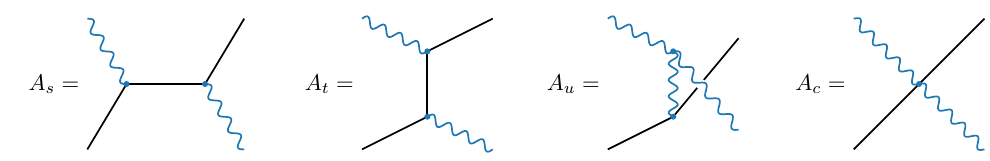
Figure 5. Illustration of the different contributions to gravitational Compton